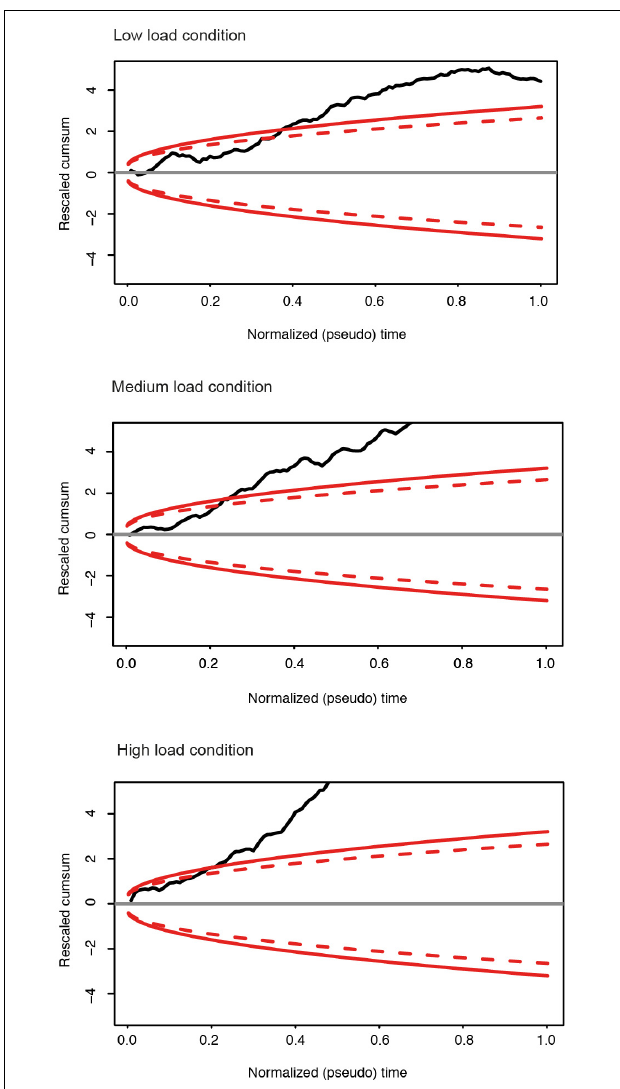
FIGURE 6 | For the different memory load conditions in the maintenance phase: Rescaled cumulative sum of the row portions of the upper triangular part of the differences matrix of each subject group (DPs vs. Controls). Red continuous: boundary of the 0.99 domain; Red dashed: boundary of the 0.95 domain. For all memory conditions, there is a significant group difference of the correlation matrices between the control and prosopagnosic